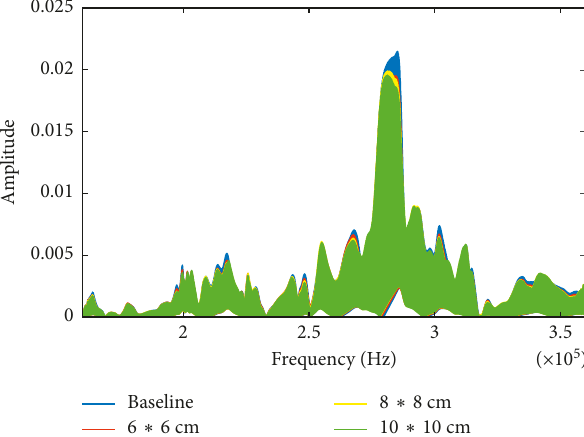
Figure 5: Comparing the spectrums obtained from four different experiments to evaluate the performance of the SuRE